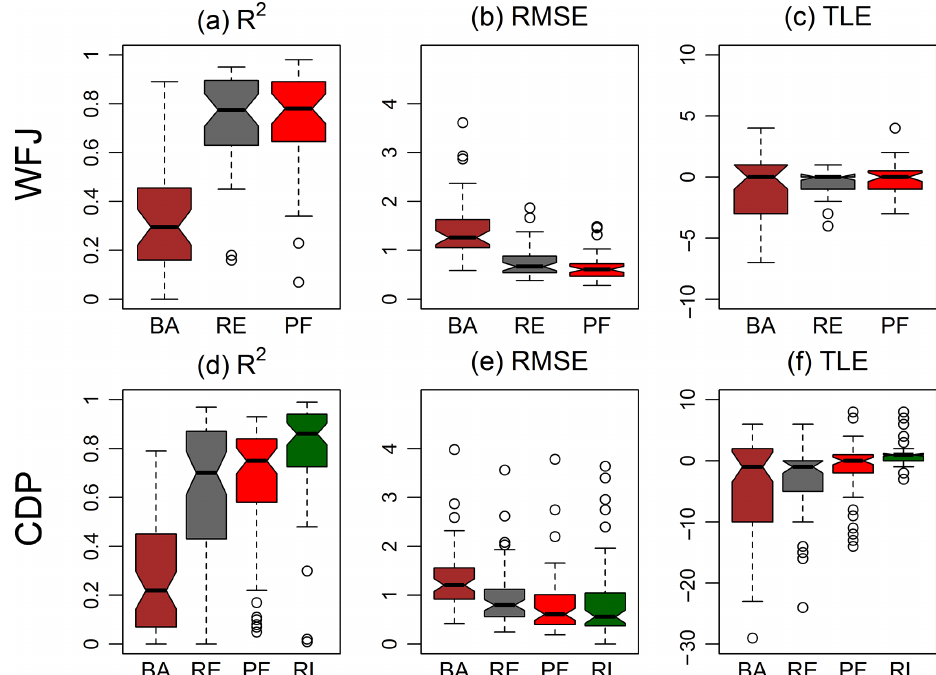
Figure 8. RMSE, R 2 and TLE for simulations of 61 ROS events at the CDP site and of 40 ROS events at the WFJ site for all models (BA, RE, PF) and the reference lysimeter (RL) available only for CDP.